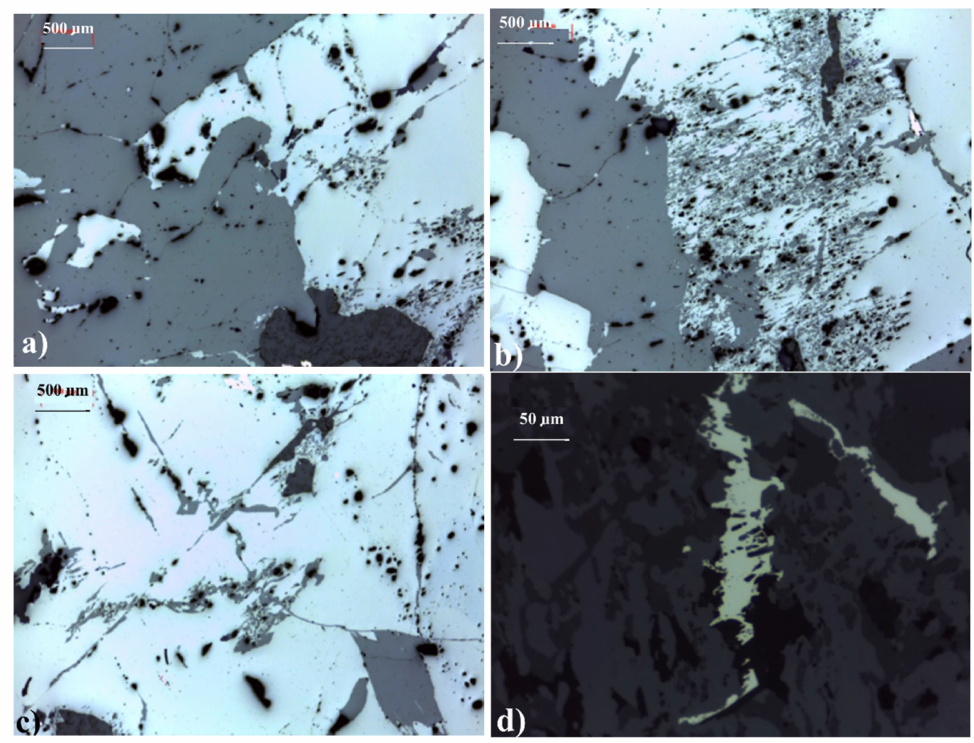
Figure 2. Photomicrographs showing textural relationships between wolframite and scheelite: ( a ) Wol- framite (white field) replaced by scheelite (gray); ( b , c ) precipitation of scheelite crystals along to fissures or fractures of wolframite; and ( d ) inclusions of sulphide (pyrite) were identified along to fractures of wolframite. Table 1. Electron microprobe data of wolframite and scheelite and calculus of structural formula based on four